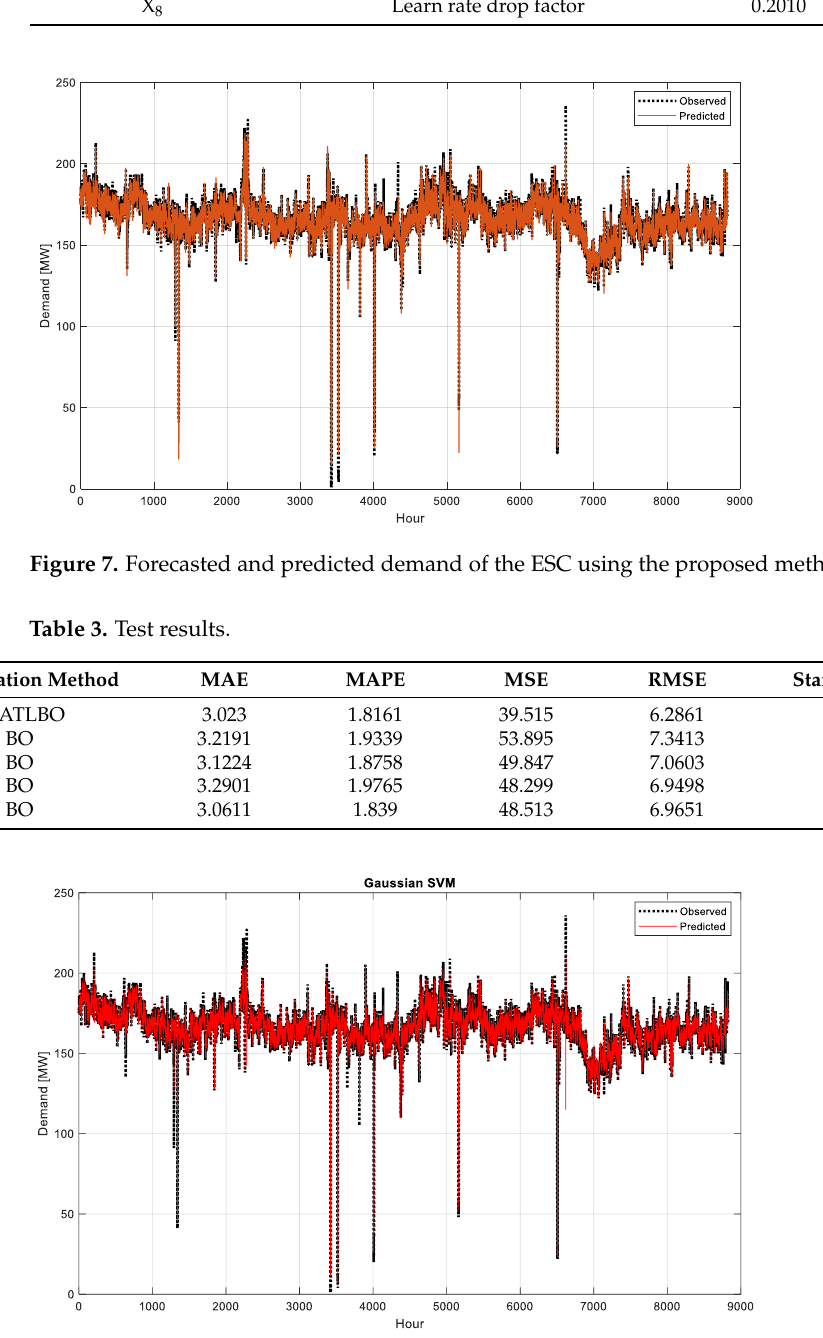
Figure 8. The ESC demand Forecasting using the Gaussian SVM model optimized using BO.